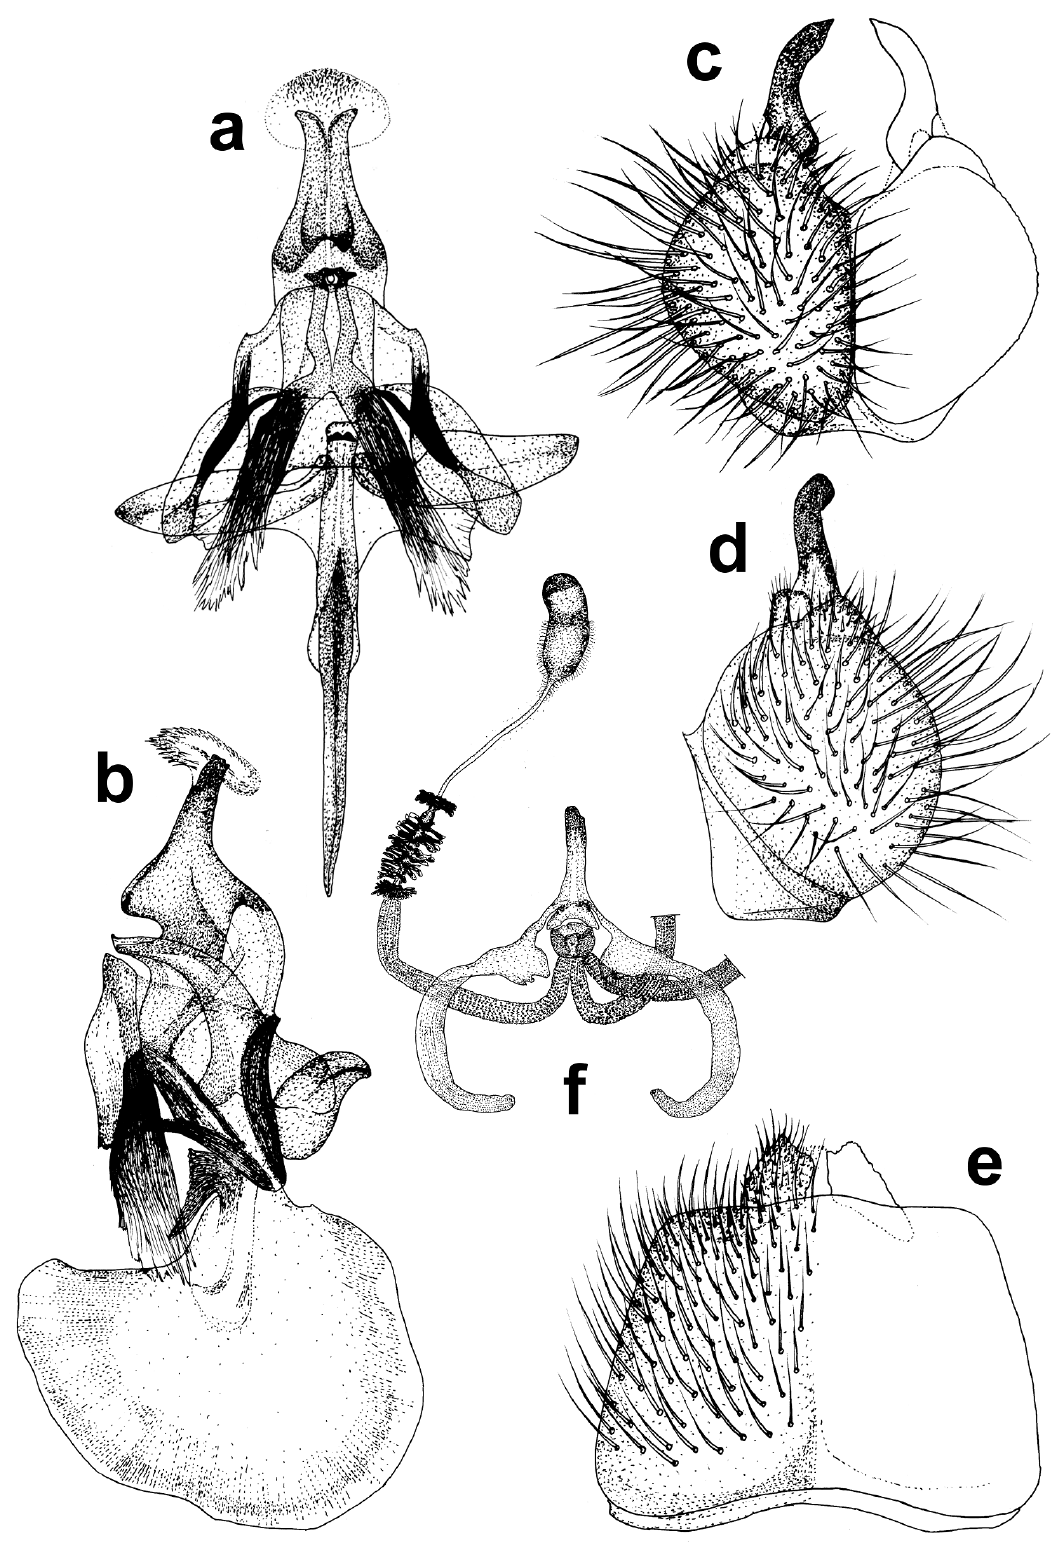
Fig. 63. Parusia cyrenaica gen. et sp. nov. a . Epiphallic complex ventral. b . Epiphallic complex lateral. c . Gonocoxite ventral. d . Gonocoxite lateral. e . Epandrium dorsal. f . Female genitalia